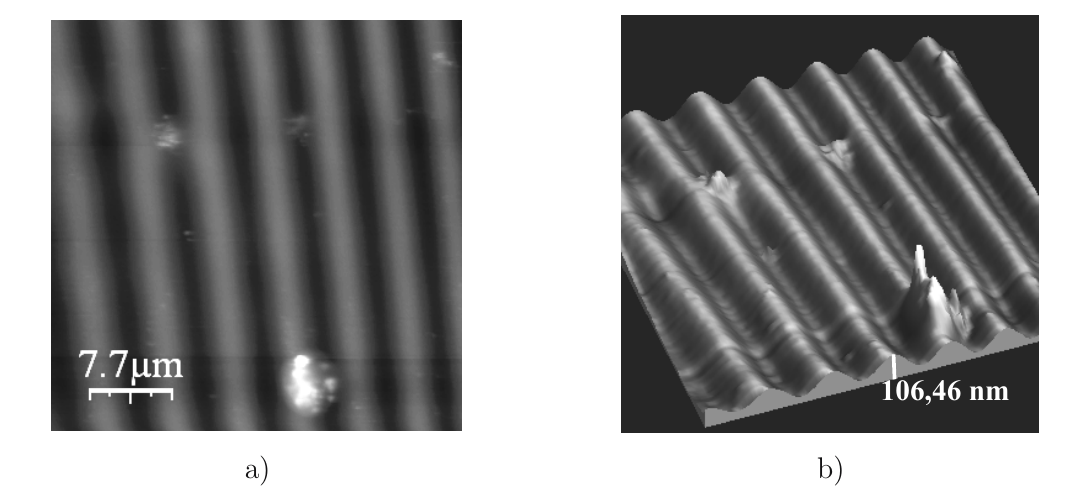
Fig. 8 Relief surface grating observed by Atomic Force Microscope in poly(amide-imide) (3b) inscribed with 514.5 nm light, s − s polarization.